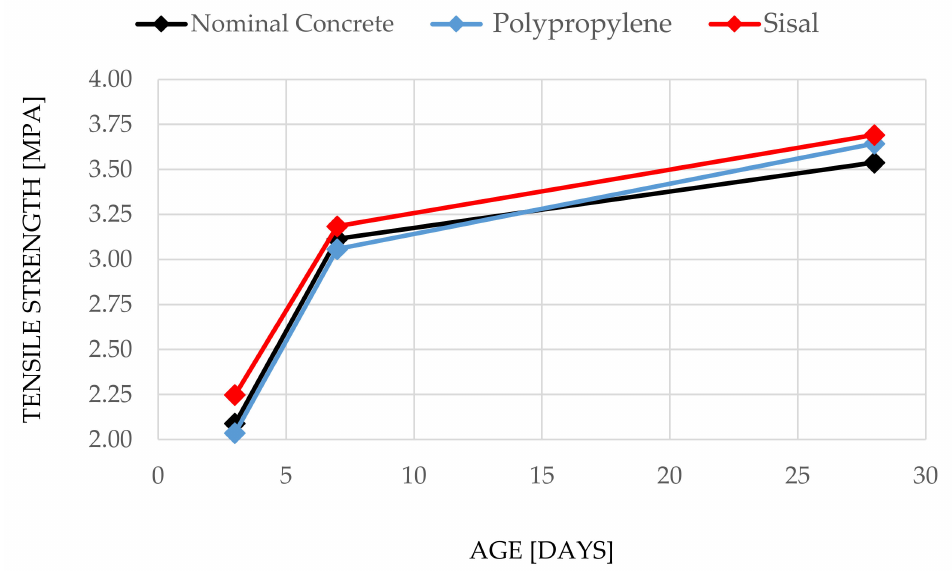
Figure 6. Tensile strengths at the ages of 3, 7 and 28 days (1 kg/cm 2 = 0.0980665 MPa).